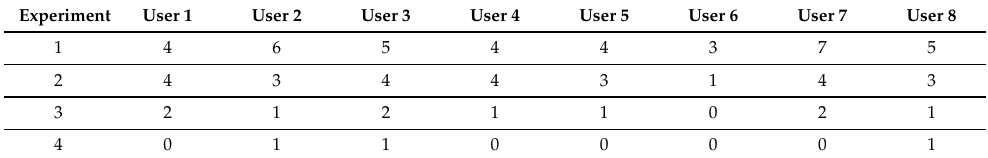
Table 4. Description of the performance with users to avoid possible collisions in a physical environment.